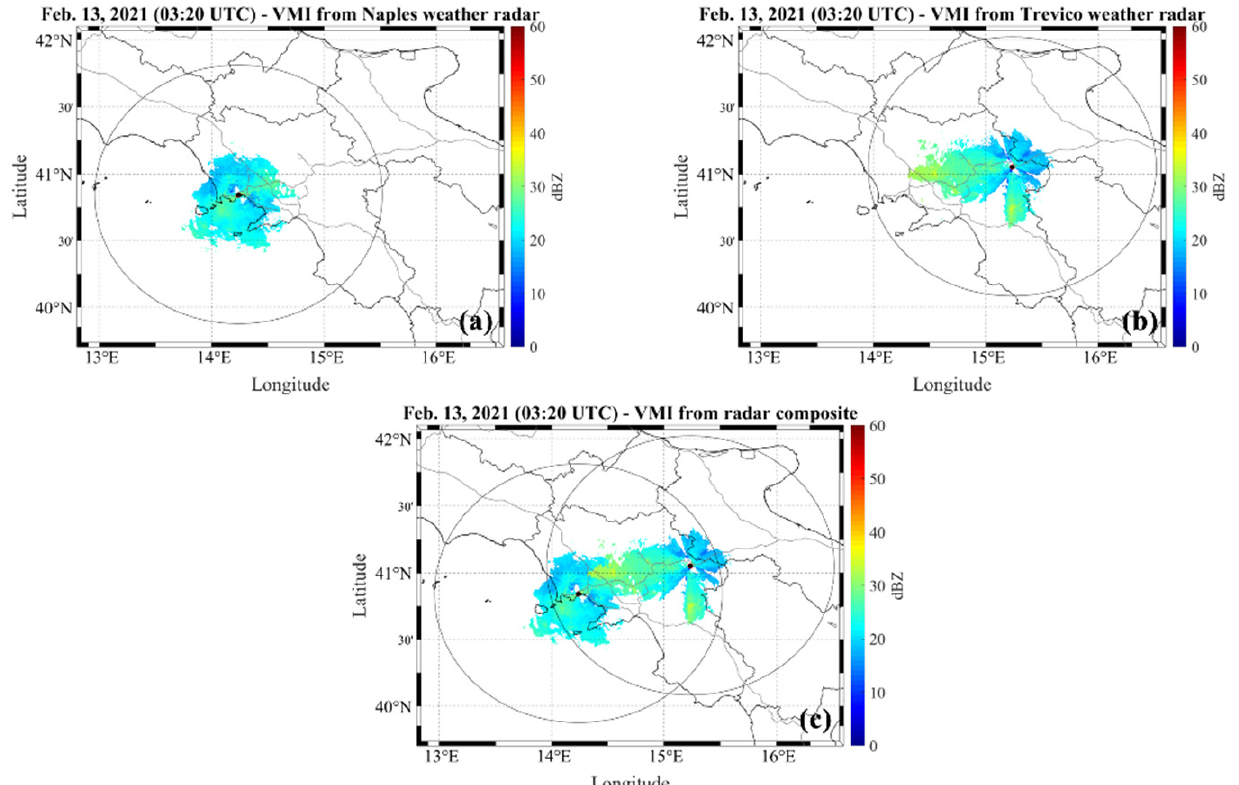
Figure 4. Reflectivity field, expressed in terms of Vertical Maximum Intensity ( VMI ) observed by the Naples ( a ) and Trevico weather radars ( b ) on 13 February 2021 (03:20 UTC). In panel ( c ), the composite product, obtained after a remapping of the VMI field on a regular cartesian grid, is shown. The reflectivity is expressed in dBZ and is color-coded according to the vertical bar.